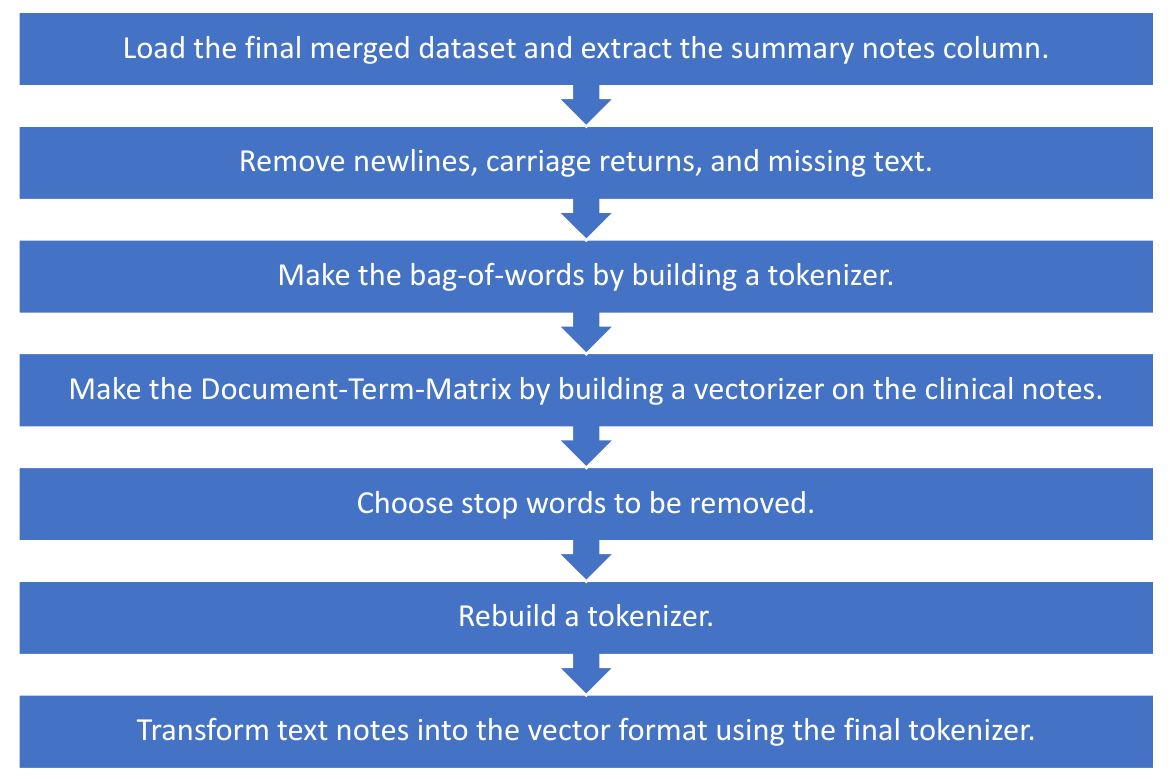
Figure 2. Preprocessing notes using NLP techniques for machine learning models.